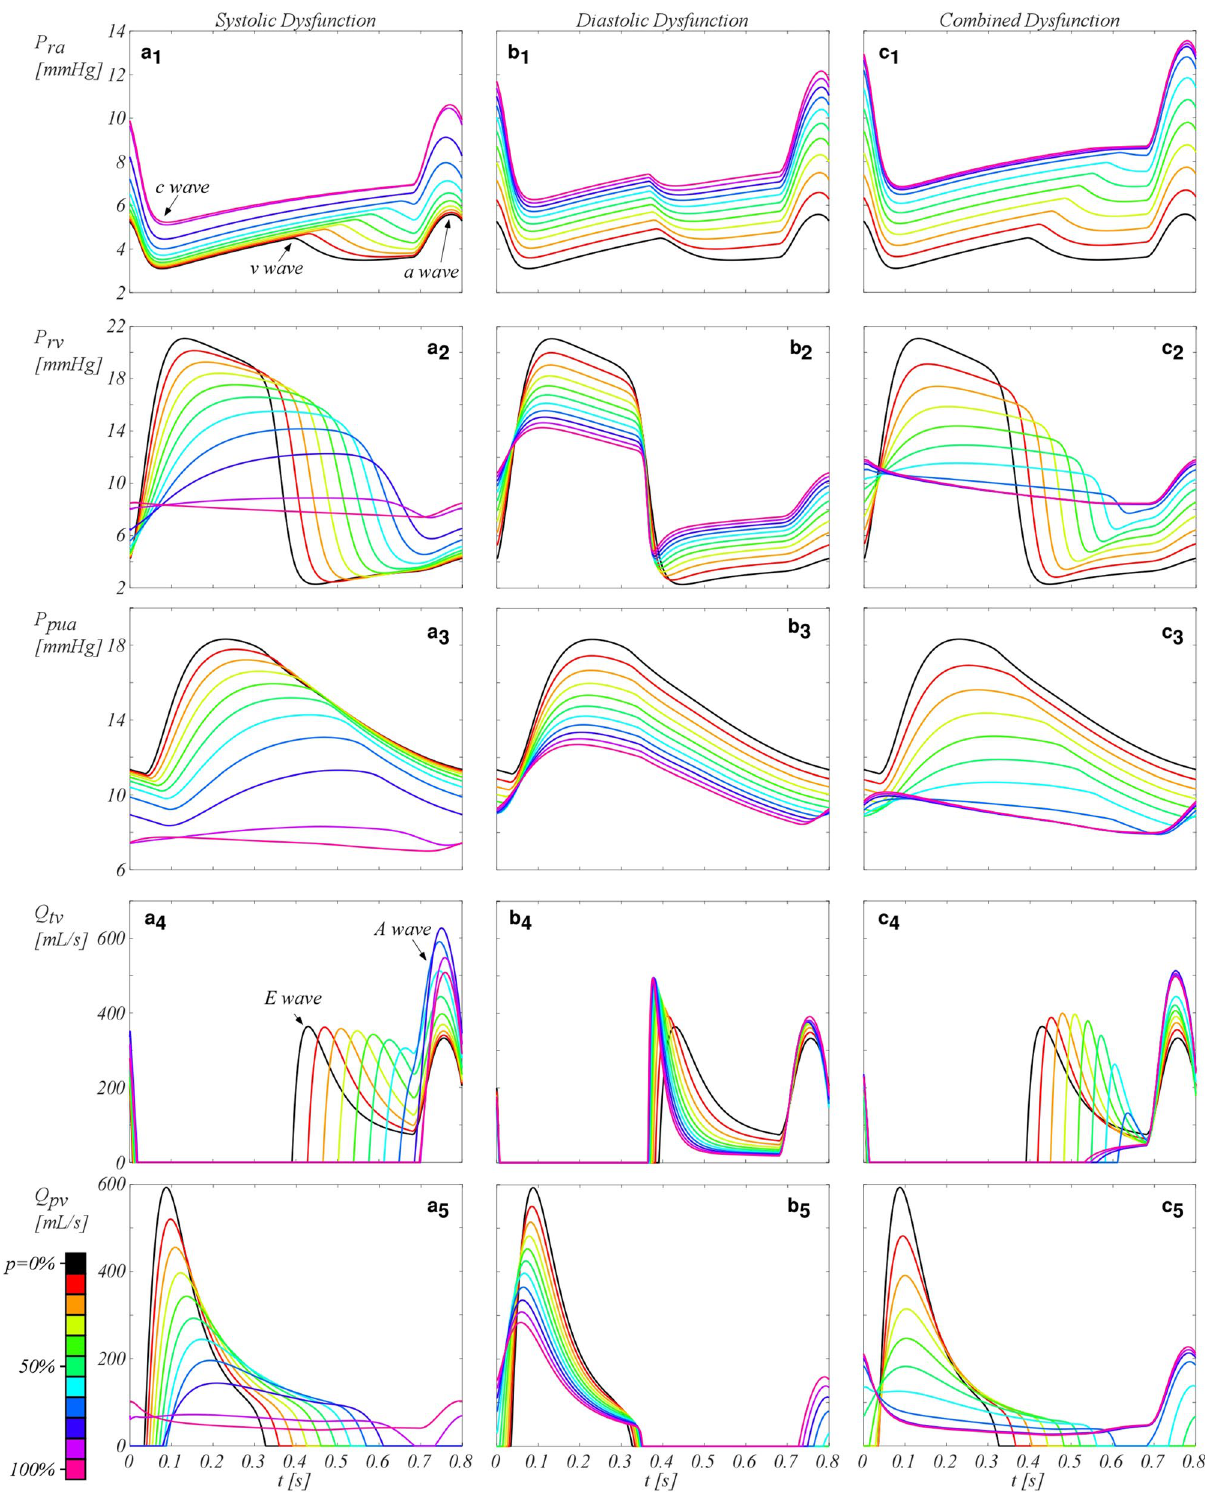
Figure 3. Pressures and flows for a heartbeat in the dysfunctions. ( a ) Systolic dysfunction, ( b ) diastolic dysfunction, and ( c ) combined dysfunction. P ra , right atrium (RA) pressure (subscript 1); P rv , right ventricle (RV) pressure (subscript 2); P PuA , pulmonary arteries (PuA) pressure (subscript 3); Q Tv , tricuspid valve flow (subscript 4); Q Pv , pulmonary valve flow (subscript 5). Black solid line, healthy configuration ( p = 0%); coloured lines; the corresponded degree of RV impairment, p , from 10 to 100%. Significant values of computed pressures and flows are reported in Table S2 of the Supplementary